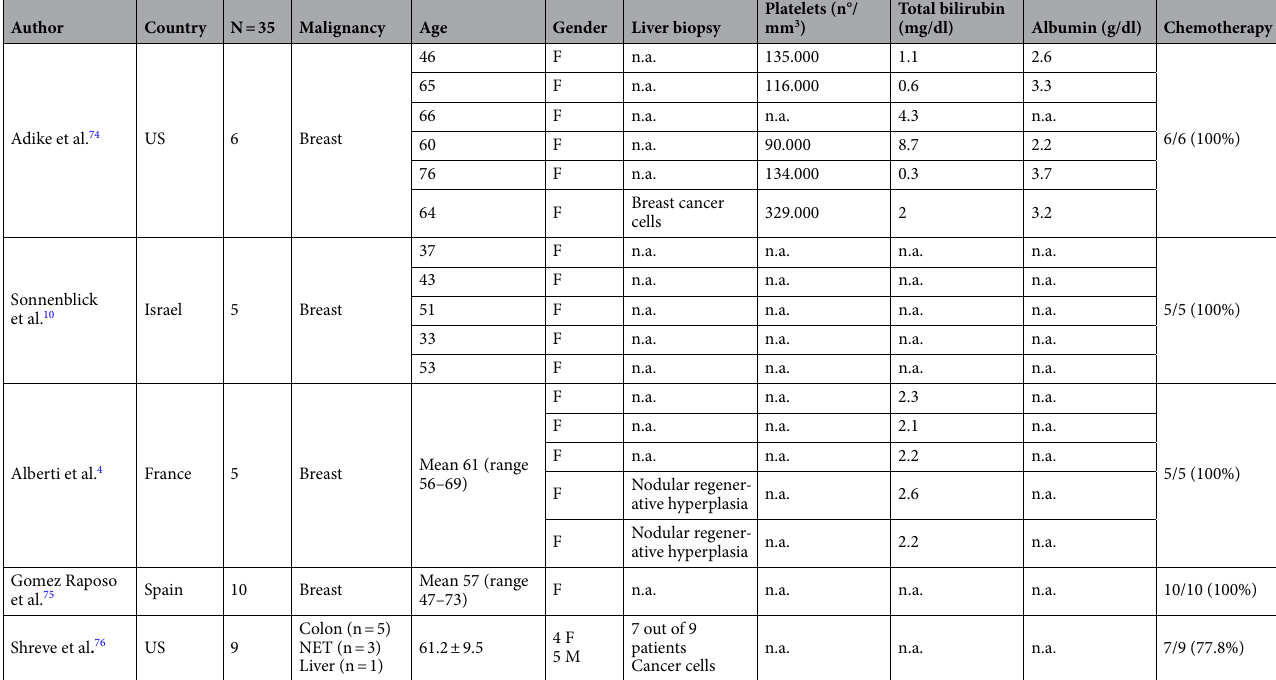
Table 2. Case series included in the final analysis.